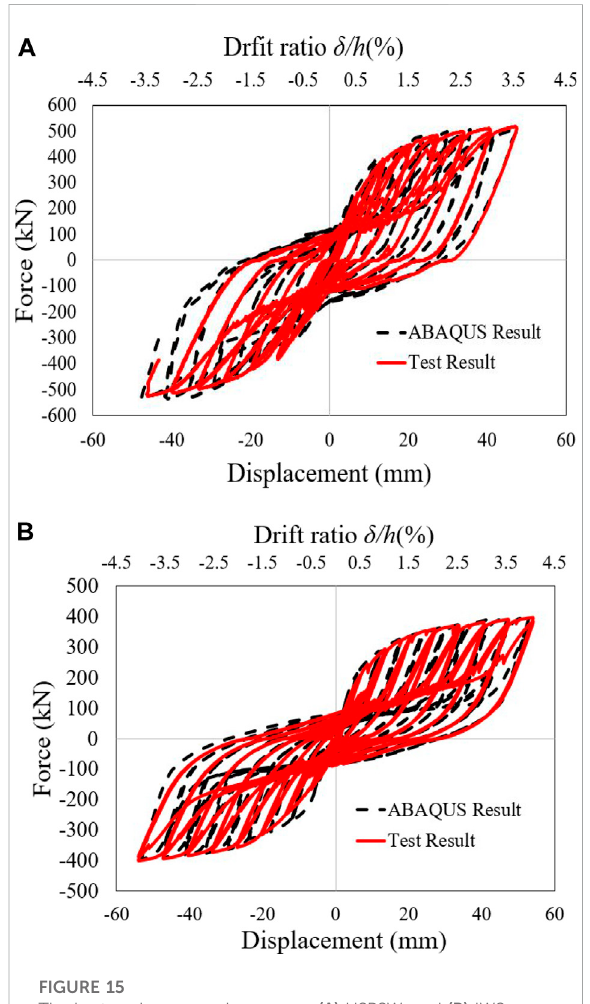
FIGURE 15 The hysteresis comparsion curves: (A) USPSW, and (B) IWS- SPSW specimen.